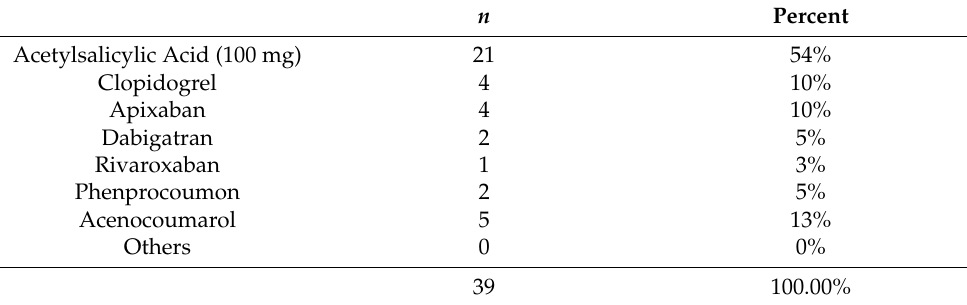
Table 6. ACAP of patients with primary